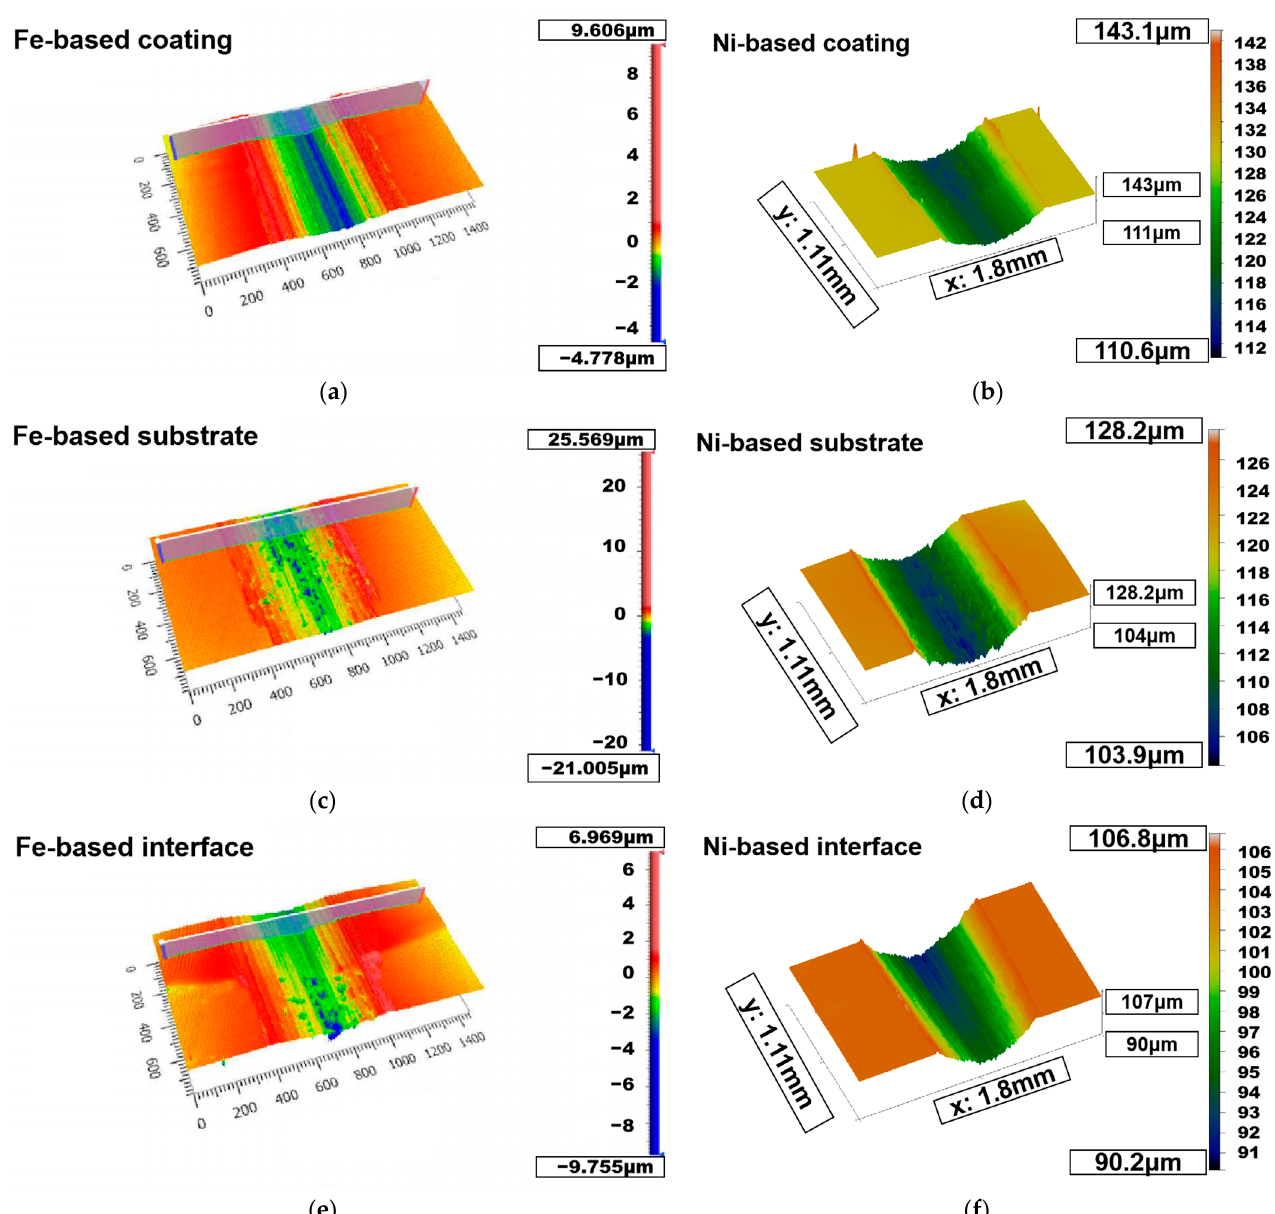
Figure 18. 3D wear appearance of two samples. These pictures show the depth of the wear in three dimensions. For precise data, please refer to Figure 19. ( a ) The 3D image wear marks of Fe-based coating; ( b ) The 3D wear marks image of Ni-based coating; ( c ) The 3D wear marks image of Fe-based substrate; ( d ) The 3D wear marks image of Ni-based substrate; ( e ) The 3D wear marks image of Fe-based interface; ( f ) The 3D wear marks image of Ni-based interface.